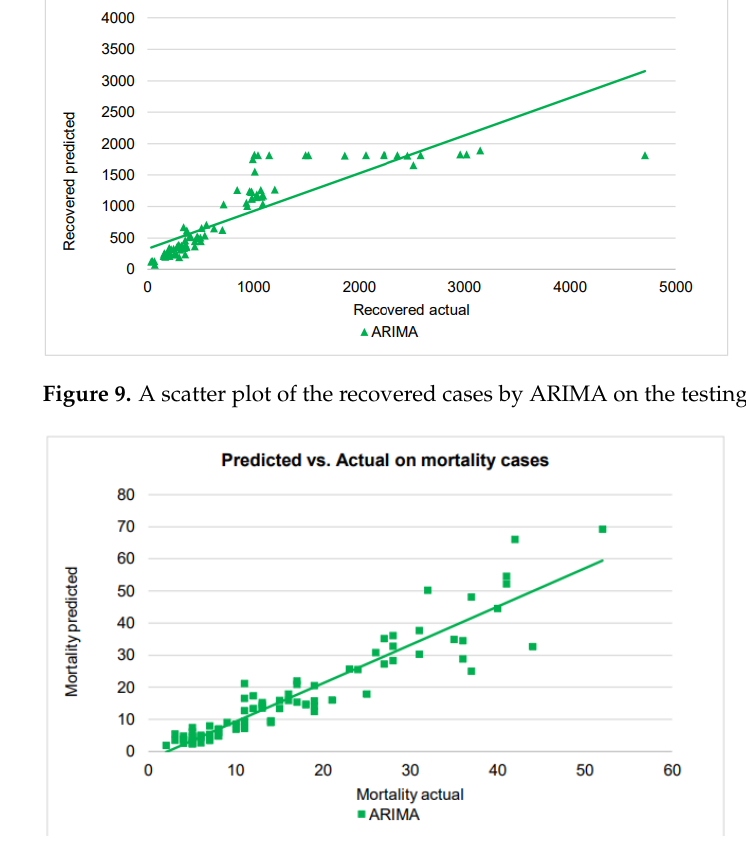
Figure 10. A scatter plot of the death cases by the ARIMA on the testing